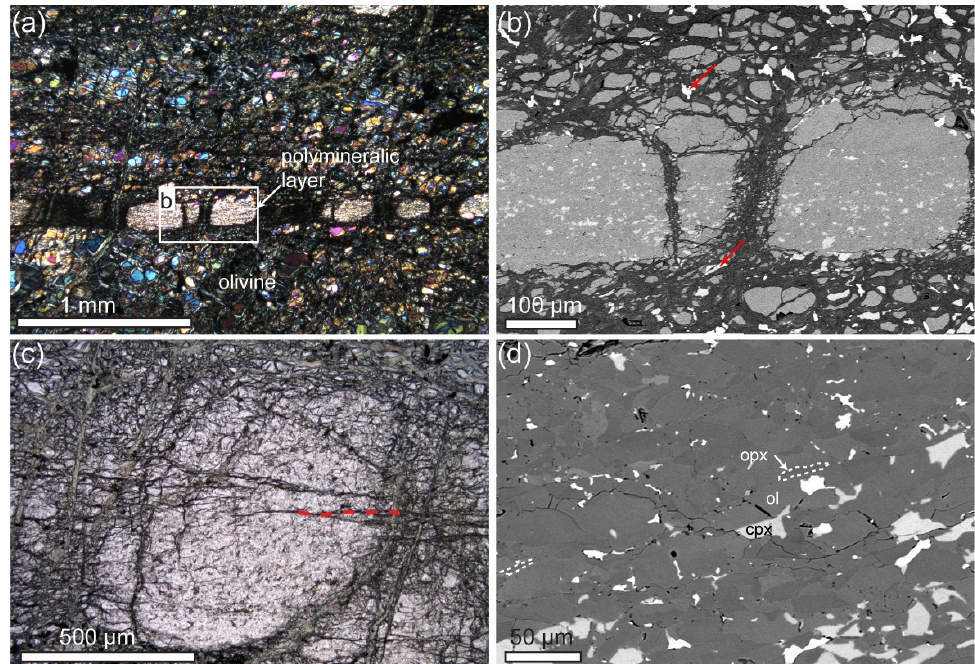
Figure 3. ( a ) Optical microscope image with crossed polarized light of a polymineralic fine-grained layer (ultramylonite) within the olivine-dominant matrix. Location of ( b ) is indicated. ( b ) Backscatter electron (BSE) image of part of the fine-grained polymineralic layer. Visible are fine-grained cpx grains (lightest gray) and opx + ol grains within the layer. Gray values for opx and ol are very similar. In addition, in this image cpx grains are visible within the olivine matrix (arrows). ( c ) Optical microscope image of part of a fine-grained layer with horizontal cracks (dashed red line). ( d ) BSE image of a fine-grained layer. Darkest grains are opx, gray is olivine and light gray is cpx. Dashed lines show thin elongated opx grains on the border of olivine grains.